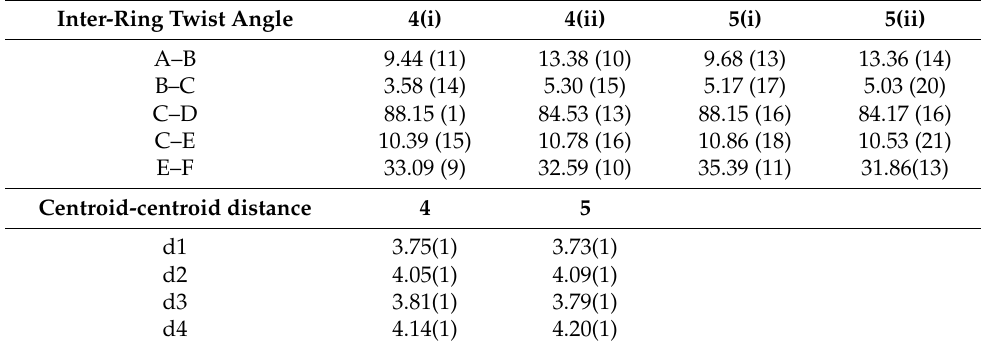
Table 2. Inter-ring twist angles ( ◦ ) and centroid-to-centroid distances (Å). (The centroid-to-centroid distances shown are longer than is conventionally shown for π – π contacts but are used in this case for ease of comparison of the structures. (i) and (ii) refer to the first and second independent molecules). Inter-Ring Twist